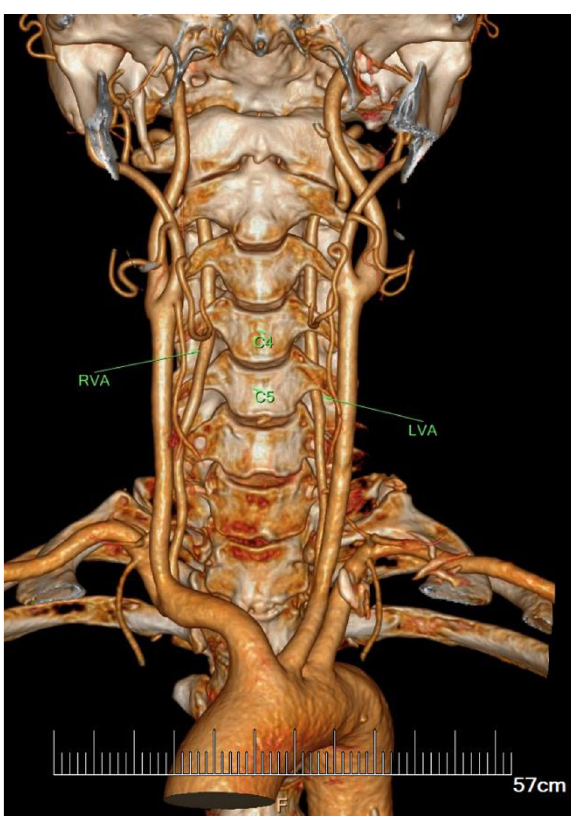
Figure 2. Typical case of the subjects with anomalous entrance at a higher level into the transverse foramen than normal (LVA: C5; RVA: